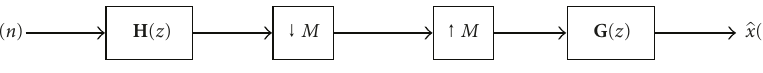
Figure 4: An M -channel cosine-modulated filter bank.